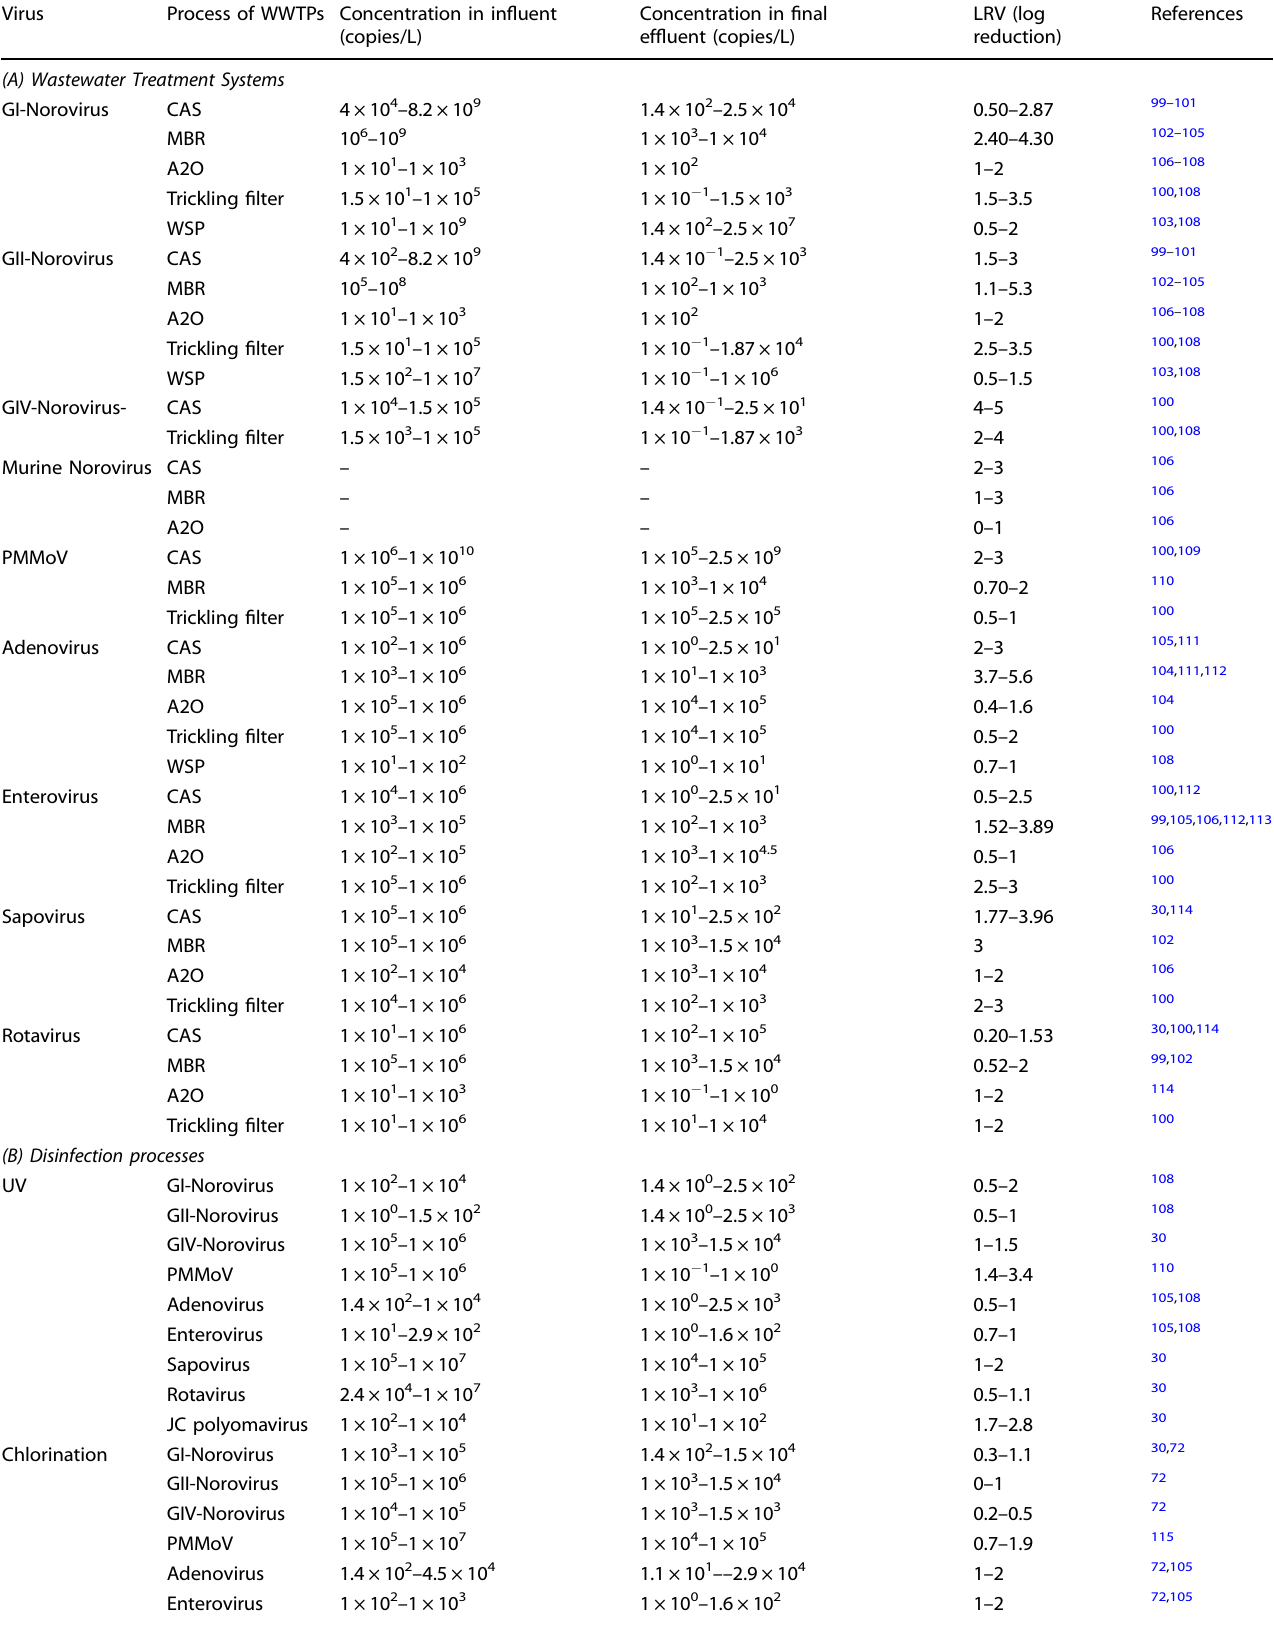
Table 2. Summary of virus concentration and log removal values in various (A) wastewater treatment, and (B) disinfection processes.